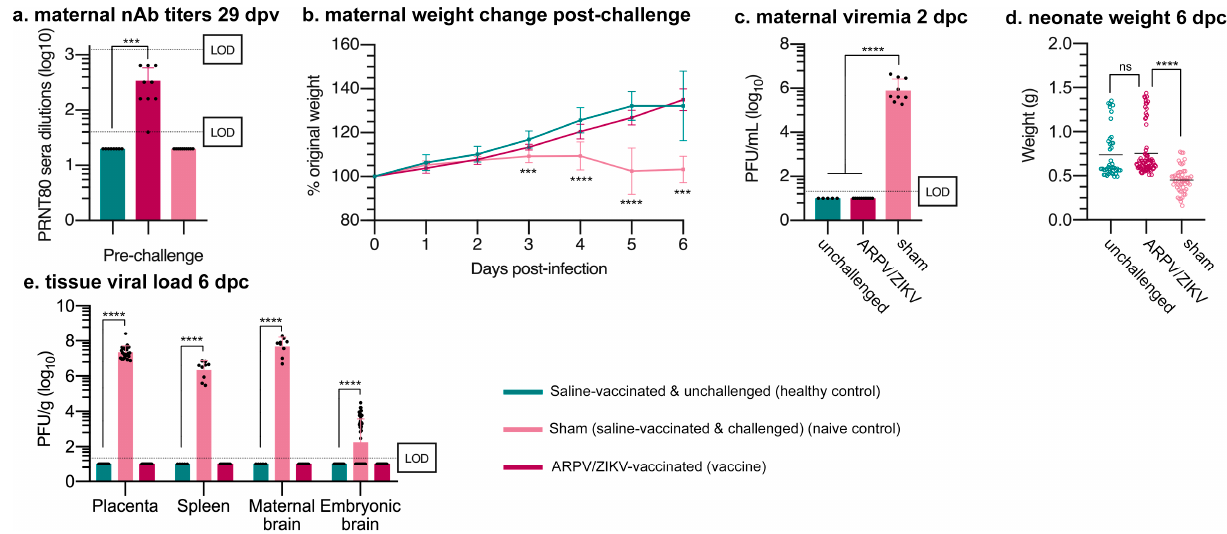
Figure 6. Single-dose ARPV/ZIKV vaccination of immune-compromised dams protects against in utero transmission after ZIKV challenge. Four-week-old female IFN- αβ R -/- mice (n = 8–10) were immunized s.c. with ARPV/ZIKV or saline 30 days prior to mating. Embryonic development was tracked upon plug detection (E0.5). ( a ) ZIKV-specific nAb titers of maternal dams was quantified by PRNT 29 days post-vaccination. Values represent the reciprocal of the highest serum dilution able to reduce ZIKV plaque formation by 80%. Dotted lines represent the lower and upper dilution limits of detection (LOD). Mice were challenged with WT ZIKV at E10.5, except healthy controls which were administered saline at challenge. ( b ) Dams were monitored daily for weight loss from 0 days post-challenge (dpc). ( c ) Maternal viremia 2 dpc (E12.5) was quantified by plaque assay on VERO 76 cells. LOD is 100 PFU/mL. Mice were euthanized 6 dpc (E16.5) to measure ( d ) neonatal weights and assess ( e ) viral load of embryonic brain and maternal placental, spleen and brain tissues by plaque assay. Columns or horizontal bars indicate mean values and error bars indicate SD of the mean. Circles represent individual mouse data points. (b) Data points represent mean values. Error bars indicate SD of the mean. Significance was determined by one-way ANOVA ( a – e ). Unless otherwise marked, asterisks indicate significance compared to healthy controls: not significant (ns), p ≤ 0.0002 (***) and p ≤ 0.0001 (****).